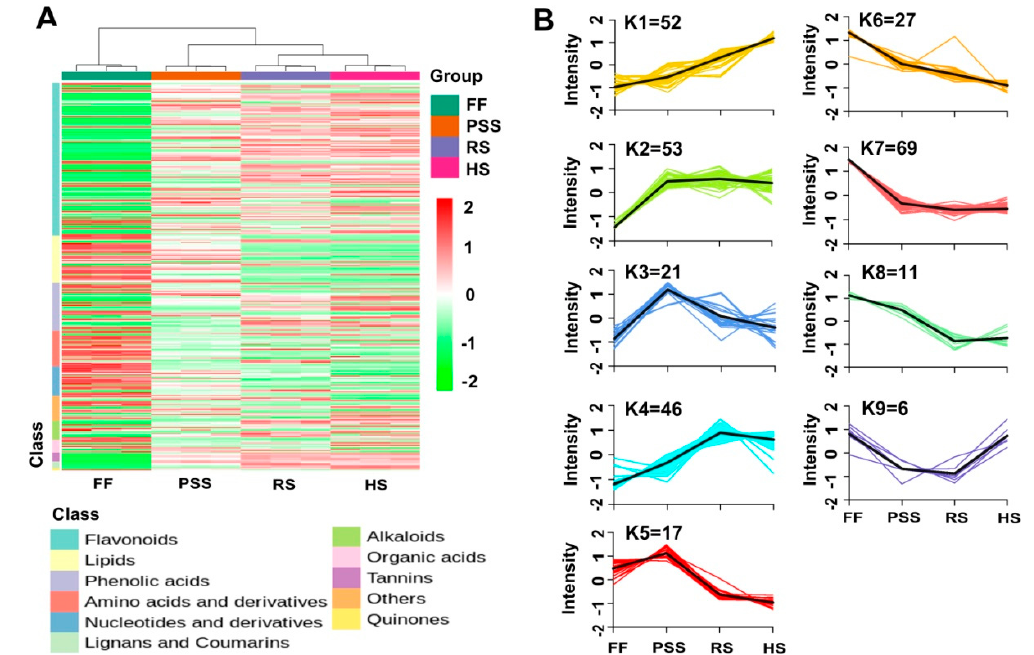
Figure 6. HCA ( A ) and K-means ( B ) cluster analysis showing the dynamic accumulation of 302 differential metabolites across four representative growth stages. K-means cluster was performed on Z-score normalized intensities. The abbreviated stage name and observation dates were the same as described in Figure 3.